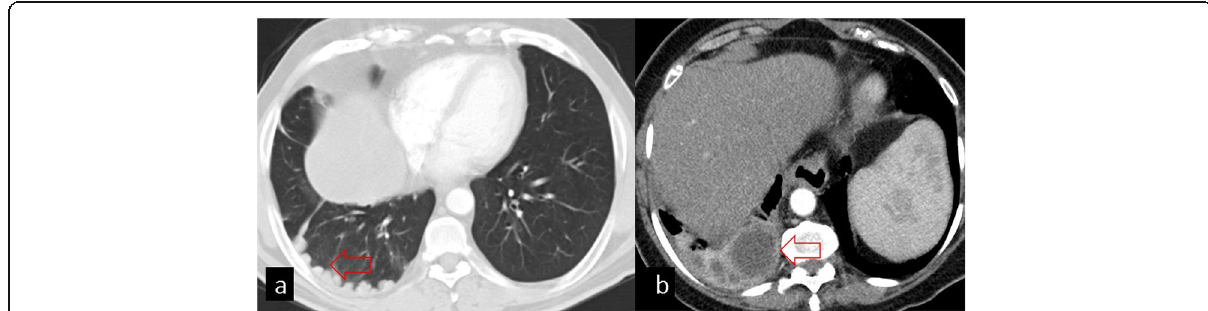
Fig. 13 a Hydatid cysts of the pleura and fissure. b Right pleural cystic lesion with peripheral contrast enhancement that belongs to empyema